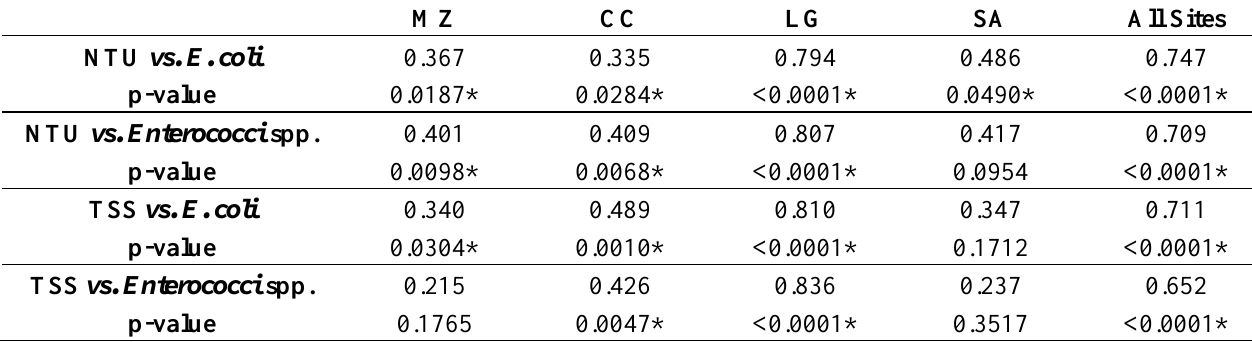
Table 4. Spearman Rank Correlation Value and p-value for Turbidity, Total Suspended Solids, E. coli and Enterococci spp. at Montezuma (MZ), Cow Creek (CC), Lower Gallinas (LG), and Spring Arroyo (SA) for 2003 &